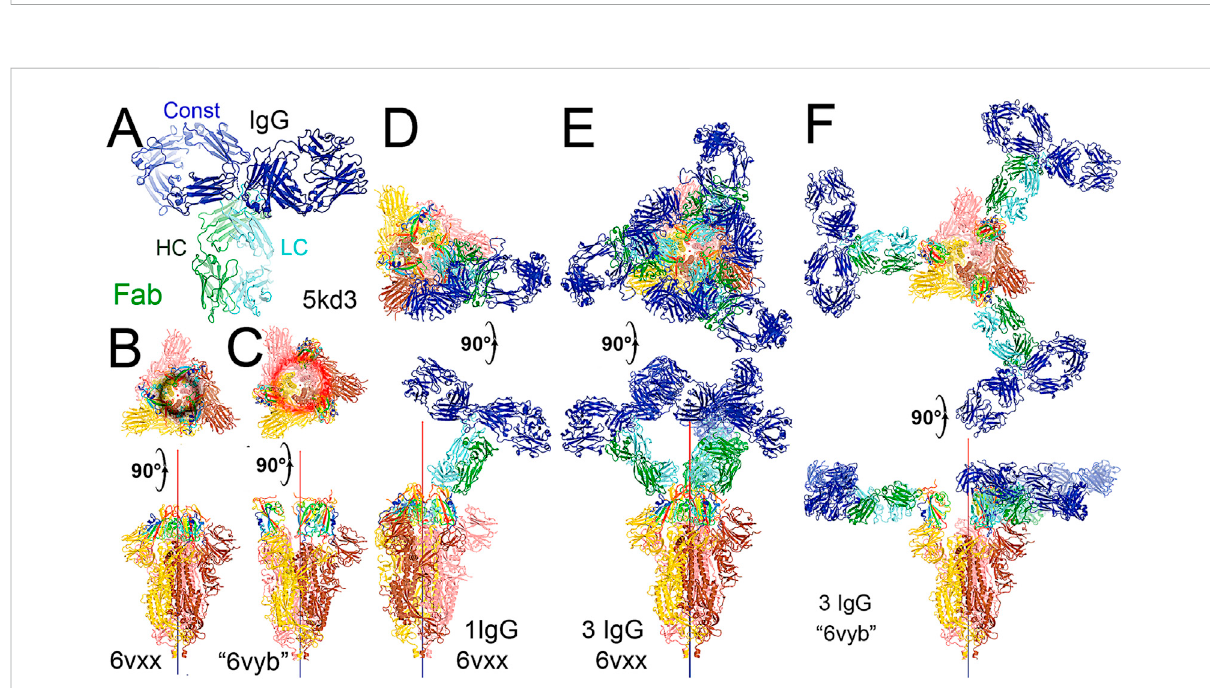
FIGURE 4 Bindingofthefull-lengthNAbC135tothespiketrimerintwoconformations. (A) Usingthefull-lengthanti-PD1IgG4torepresentthefull-length C135,constantdomainsareinblue,heavychainingreen,andlightchainincyan. (B) Twoorthogonalviewsoftheclosedspiketrimer(fromPDB:6vxx coordinates). (C) Two orthogonal views of the fully open (open-1) spike trimer (using symmetrized PDB: 6vyb coordinates). (D) Binding of one NAb C135 to the closed spike trimer in two orthogonal views. (E) Binding of three NAb C135 to the closed spike trimer in two orthogonal views. (F) Binding of three NAb C135 to the open spike